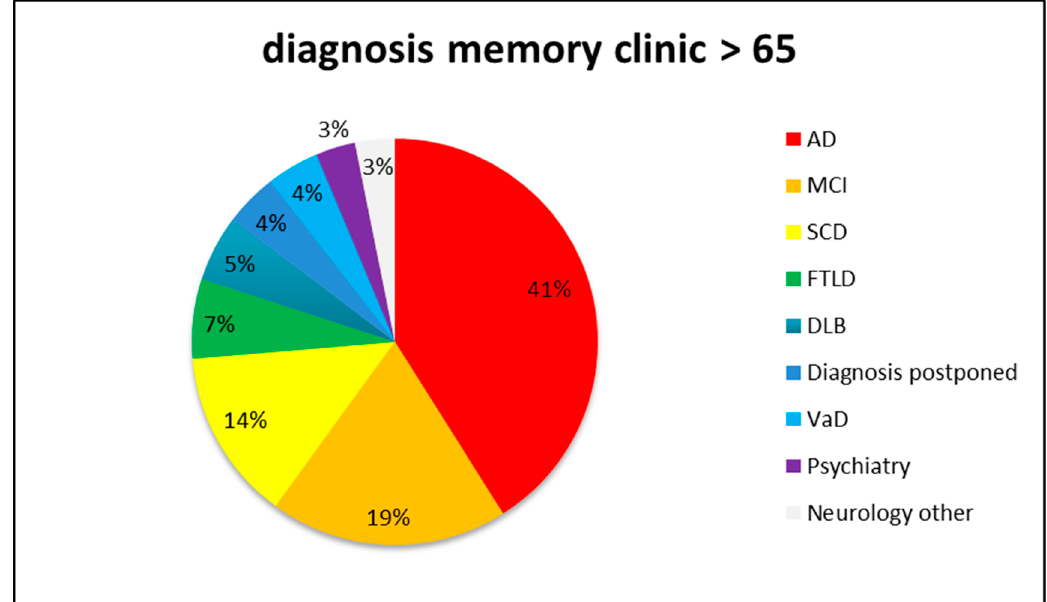
Figure 1. The proportion of dementia caused by various neurodegenerative diseases. AD = Alzheimer’s disease, MCI = mild cognitive impairment, SCD = subjective cognitive decline, FTLD = frontotemporal dementia, DLB = dementia with Lewy bodies, and VaD = vascular dementia.